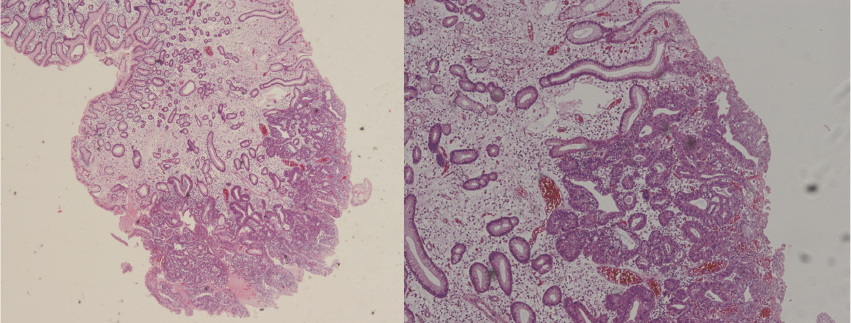
Figure 2: Pathologic findings. (A) Adenomatous change in the background of hyperplastic polyp (H&E, × 12.5). (B) Foci of carcinomatous transformation in the adenomatous lesion (H&E, ×